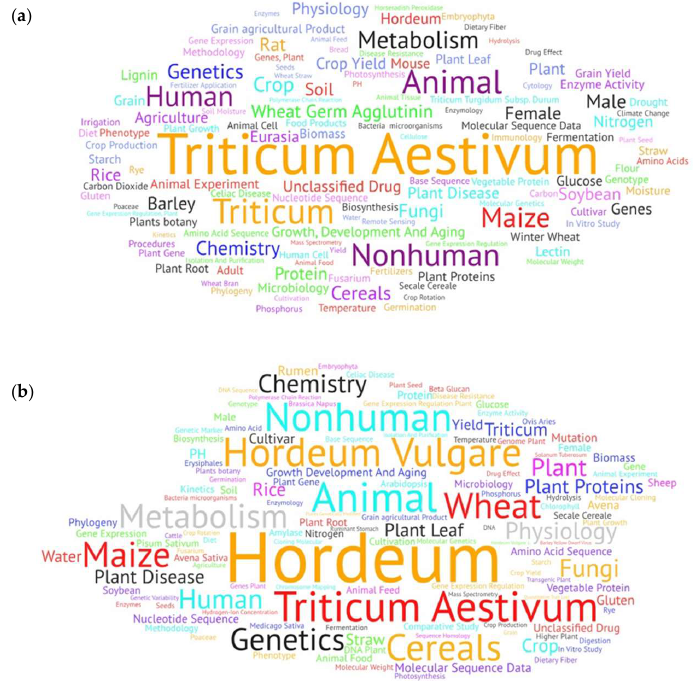
Figure 6. Figure 6. Word cloud based on the main keywords related to wheat ( a ) and barley ( b ) in worldwide research.